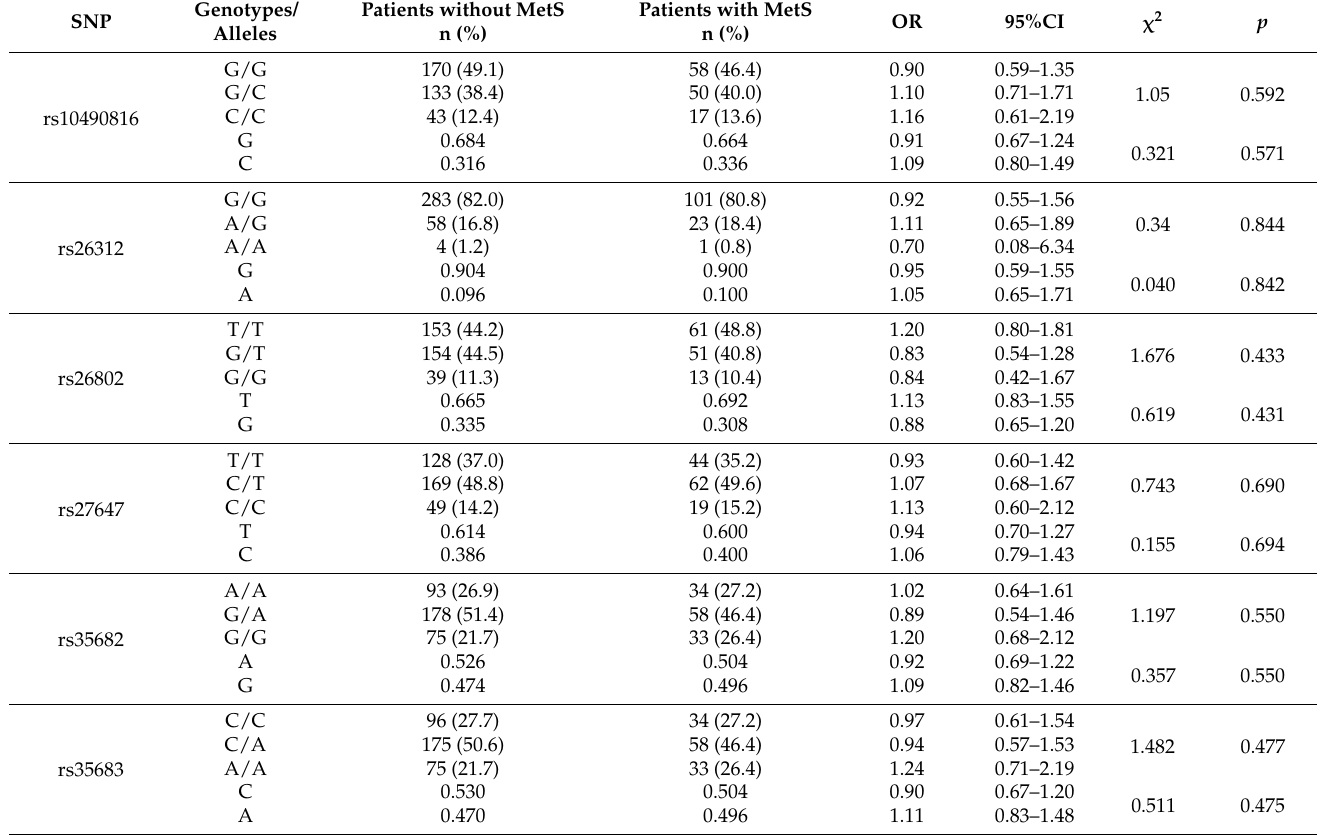
Table 5. Distribution of alleles and genotypes of GHRL polymorphisms in groups of